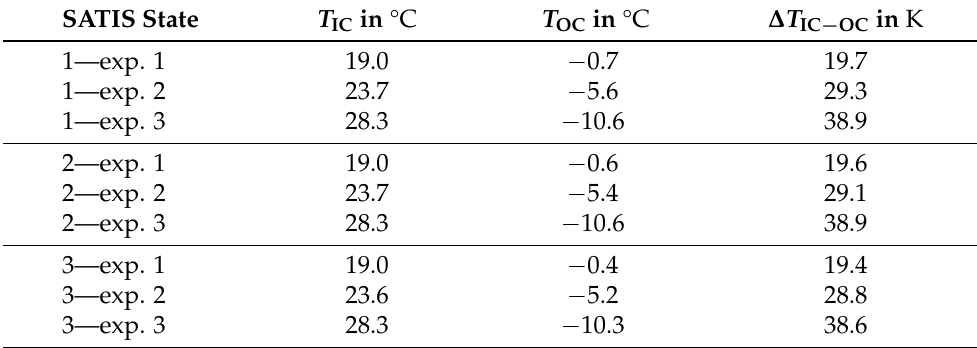
Table 1. Mean measured indoor ( T IC ) and outdoor ( T OC ) air temperatures as well as the absolute temperature differences ( ∆ T IC OC ) for the experiments. −